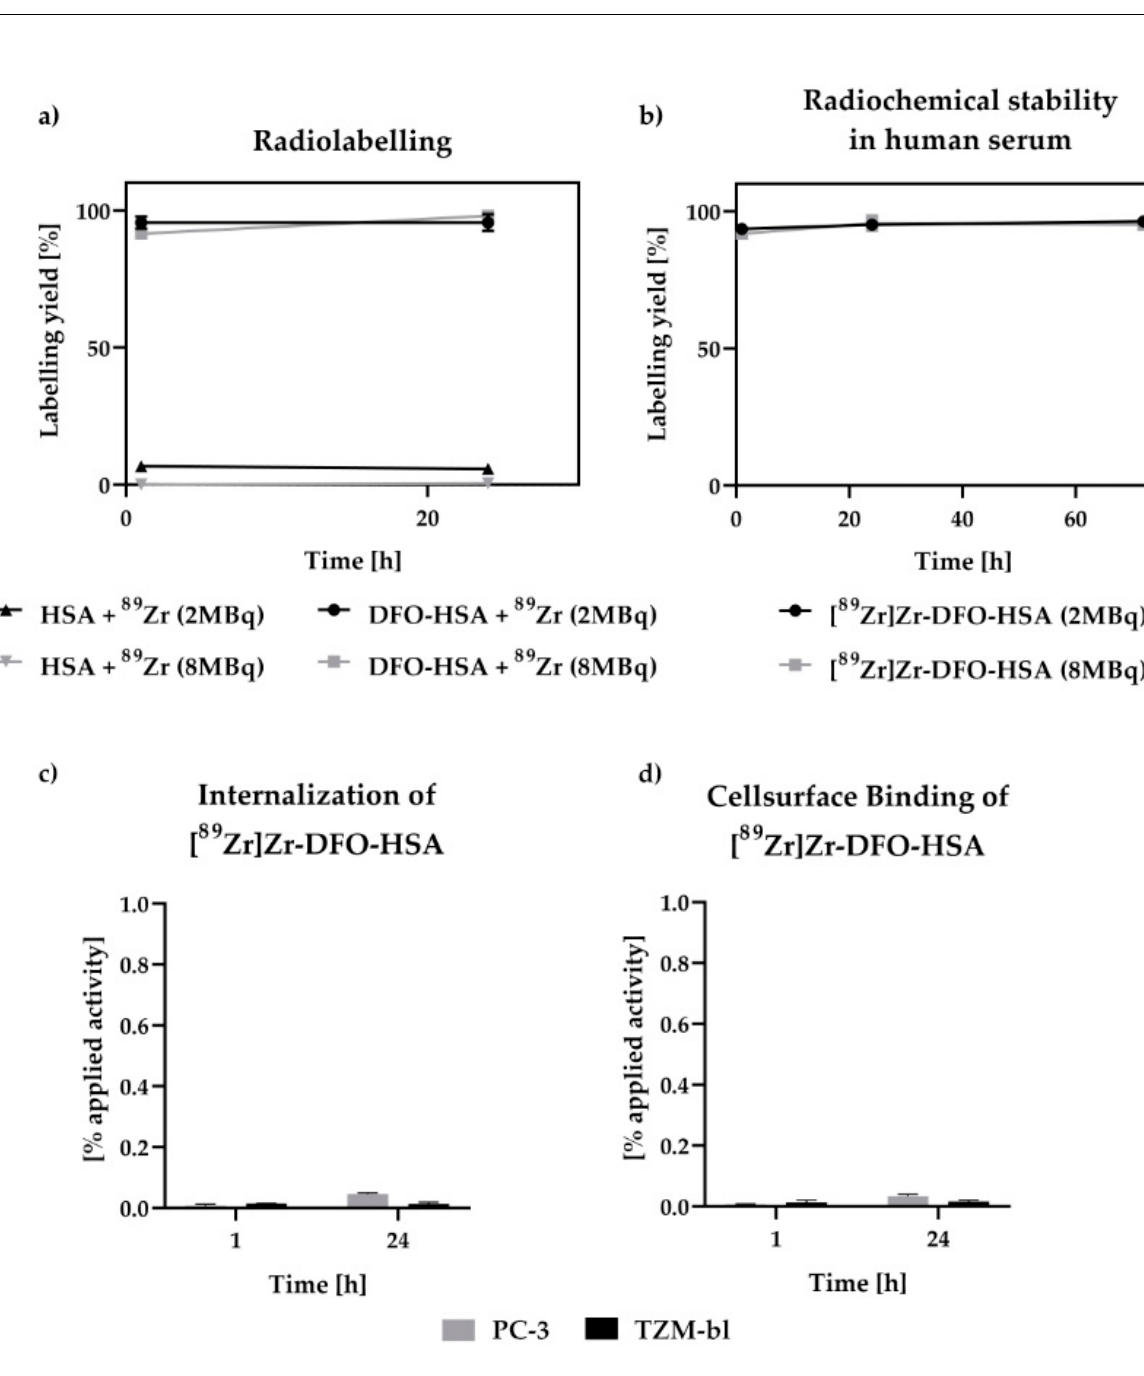
Figure 1. Depicted is the percentage of zirconium-89 complexed by DFO-HSA over a measurement period of 24 h. DFO-HSA was labeled with 2 or 8 MBq zirconium-89 respectively. A radiochemical yield greater than 95% was achieved after 1 h with 2 MBq zirconium-89, whereas this value was only achieved after 24 h with 8 MBq ( a ). Chelator-independent labeling of zirconium to HSA was neglectable. In both cases, the complex was stable in human serum for up to 72 h ( b ). The internalization process is evaluated over 24 h ( c ). No significant amount of [ 89 Zr]Zr-DFO-HSA or zirconium-89 was detected within or bound ( d ) to either TZM-bl or PC-3 cells. By these results, it was demonstrated that DFO-HSA was successfully labeled with 89 Zr and proven to be stable in human